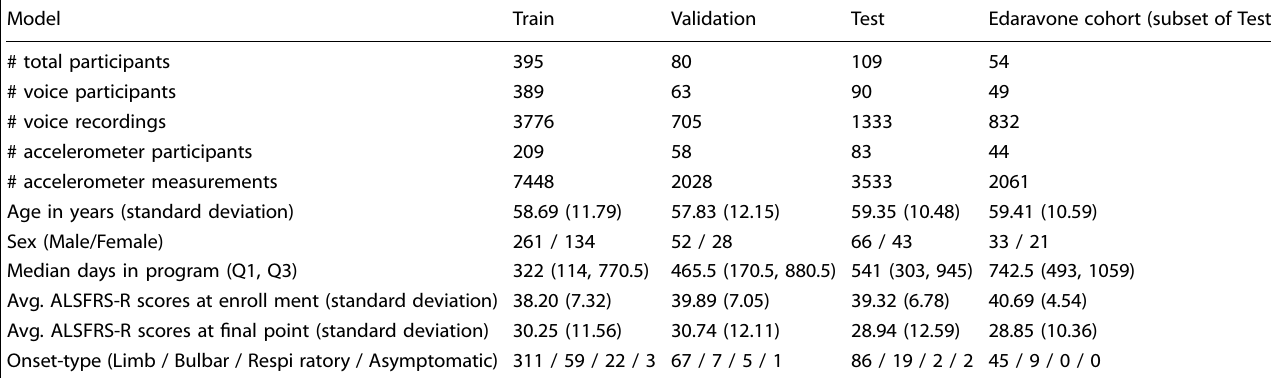
Table 1. Demographic and clinical characteristics of study participants: The number of participants and number of recordings/measurements (in parenthesis) in the training, validation, and test sets. The rightmost column shows the set of participants in the Edaravone cohort (a subset of the test